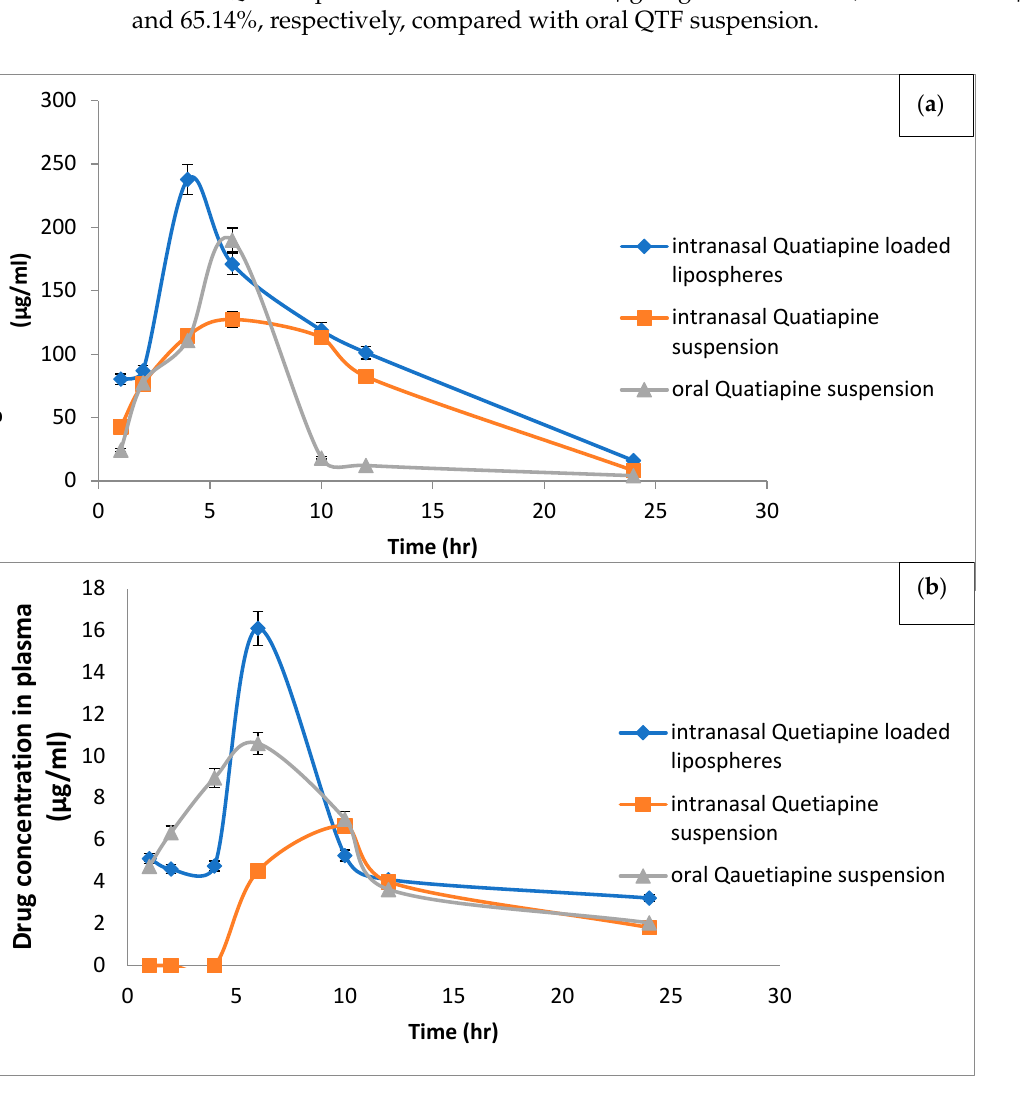
Figure 6. QTF concentration levels in ( a ) the brain and ( b ) plasma in rats. Table 5. Pharmacokinetic parameters of QTF in plasma and brain tissues after intranasal and oral administration.